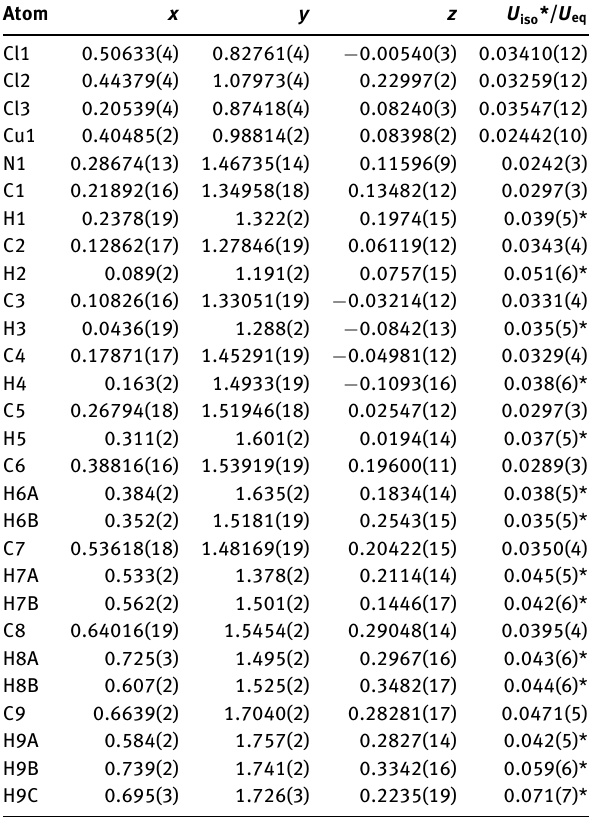
Table 2: Fractional atomic coordinates and isotropic or equivalent isotropic displacement parameters (Å 2